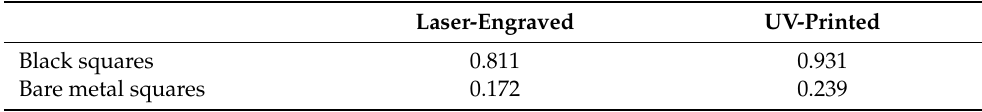
Figure 6. Laser-engraved pattern ( a ) optical and ( b ) thermal images and UV-printed pattern ( c ) optical and ( d ) thermal images. Table 4. Emissivity coefficients ( ε ) of the calibration targets.